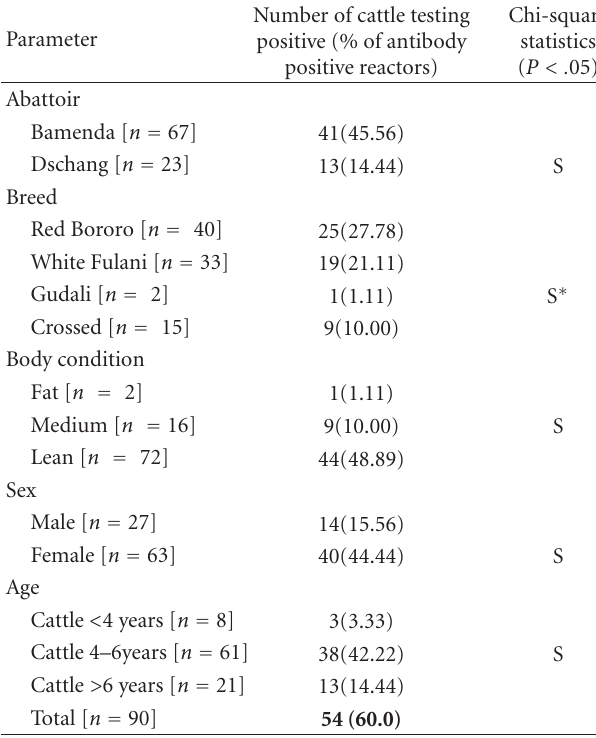
Table 2: Detection of anti-TB antibodies in 90 randomly selected cattle using the lateral-flow rapid